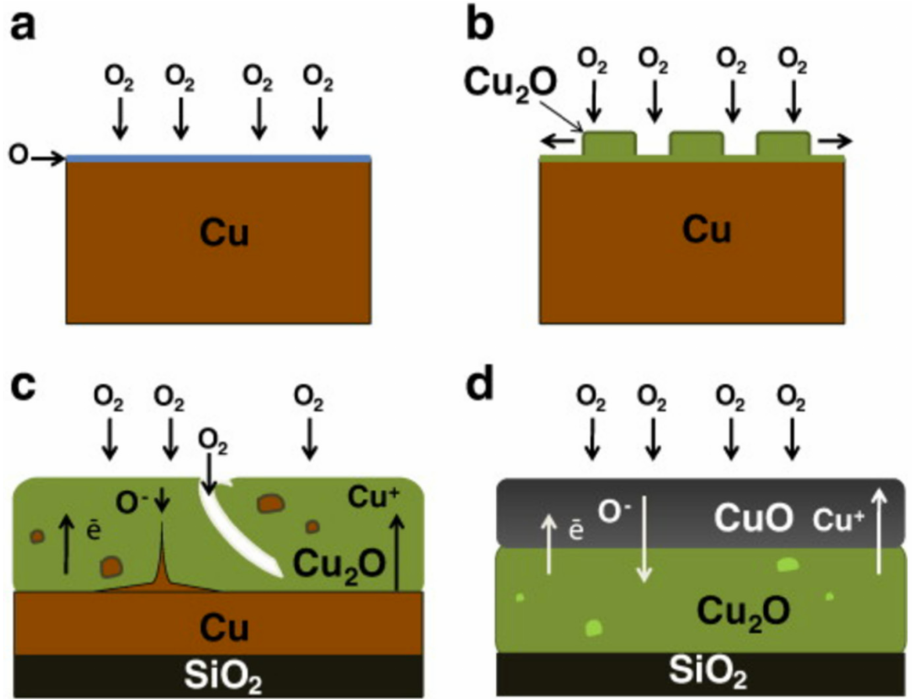
Figure 5. The growth mechanism of CuO thin films using thermal oxidation. ( a ) Chemical adsorption of oxygen on the cooper surface and formation of the oxide layer. ( b ) Nucleation and formation of Cu 2 O on the top of the Cu surface. ( c ) Cu ions diffuse and ionize oxygen atoms, which are then incorporated into the oxide network. Consequently, new oxide layers are formed at the interface oxide/oxygen, and the thickness of Cu 2 O is increased. ( d ) Transformation of Cu 2 O into CuO at a high annealing temperature (complete oxidation). Reprinted with permission from